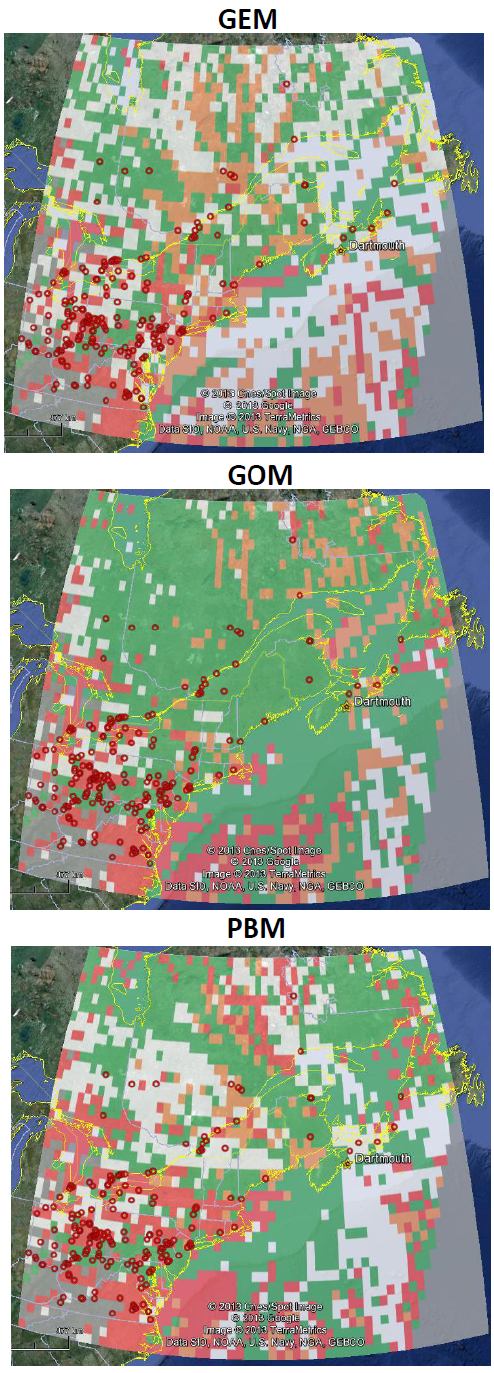
Fig. 8. Geographical distribution of the largest seasonal CWTs for GEM, GOM and PBM. Winter: grid cells with white color; Spring: green; Summer: orange; and Fall: red. Grid cells shown in grey were not used in the calculation of CWT for any season because there were < 2 trajectory segment endpoints. Red circles are the locations of known industrial Hg sources emitting > 5kg of Hgyr − 1 in 2010 and